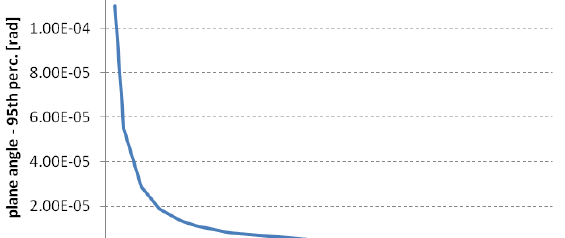
Fig. 2. Plane definition.